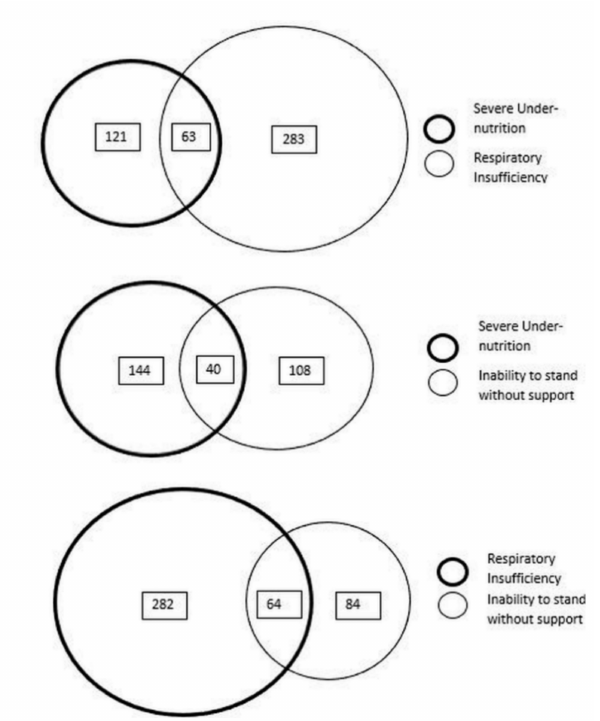
Figure 3. Overlapping ($) of indicators among adults ( ≥ 15 years) with TB (without known drug- resistant disease at diagnosis) classified as ‘high risk of severe illness’ at notification from public health facilities of 16 districts in Karnataka, India, 15 October to 30 November 2020 (n = 538) (@) . ($) Size of circles is only representational and not directly proportional to the numbers under each category, value mentioned in boxes indicates the number with ‘high risk of severe illness’; (@) of 3020 people with TB, a total of 1531 were screened, of 1531, a total of 538 had ‘high risk of severe